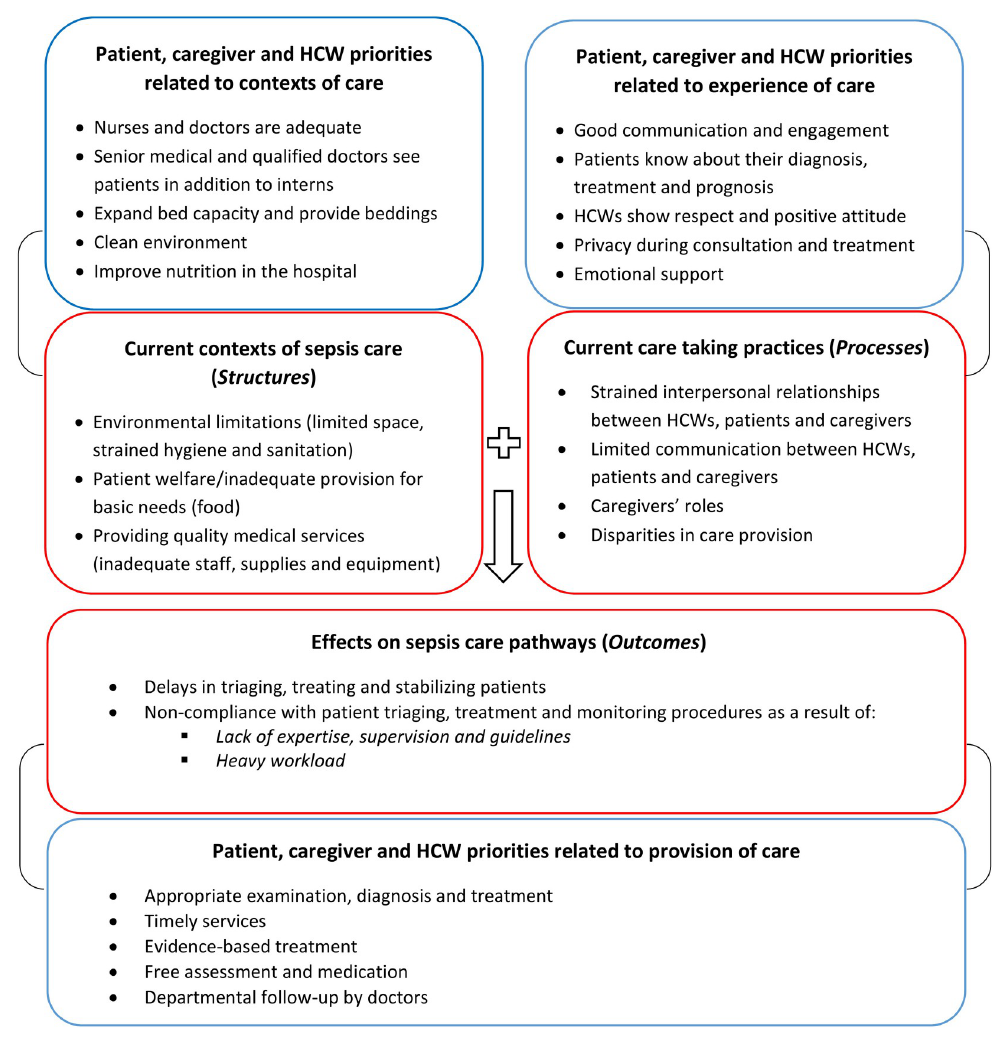
Fig 1. Themes and sub-themes emerging from the semi-structured interviews (adapted from Donabedian model and WHO quality